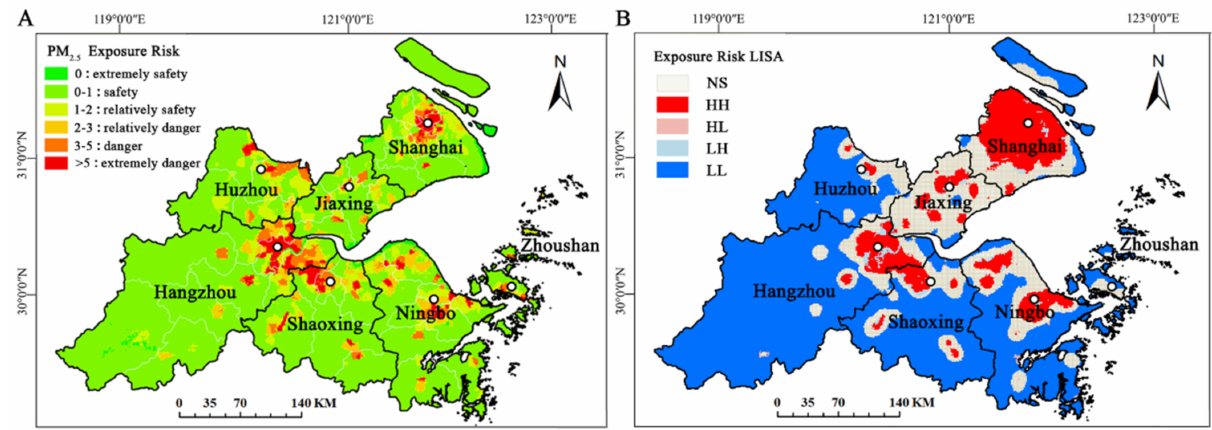
Figure 9. Maps of PM 2.5 exposure risk ( A ) and LISA agglomeration ( B ) in SHB,